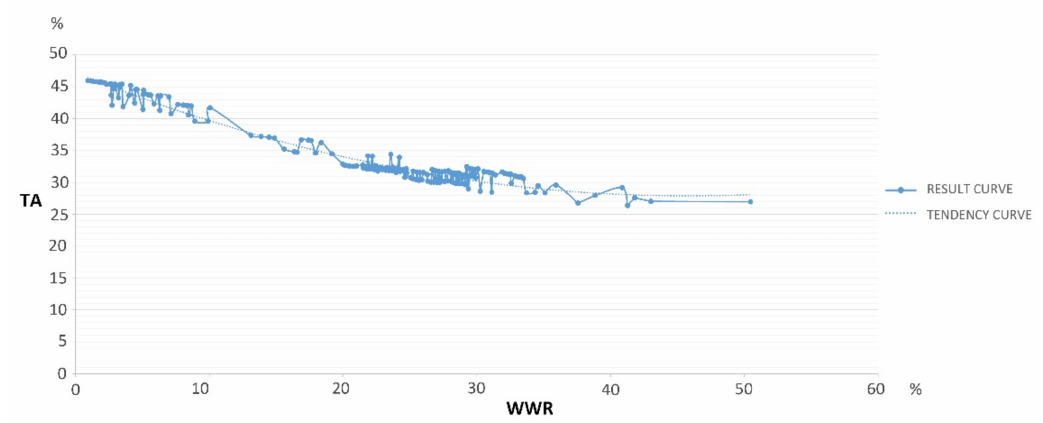
Figure 12. Relationship between TA (y-axis) and WWR (x-axis).